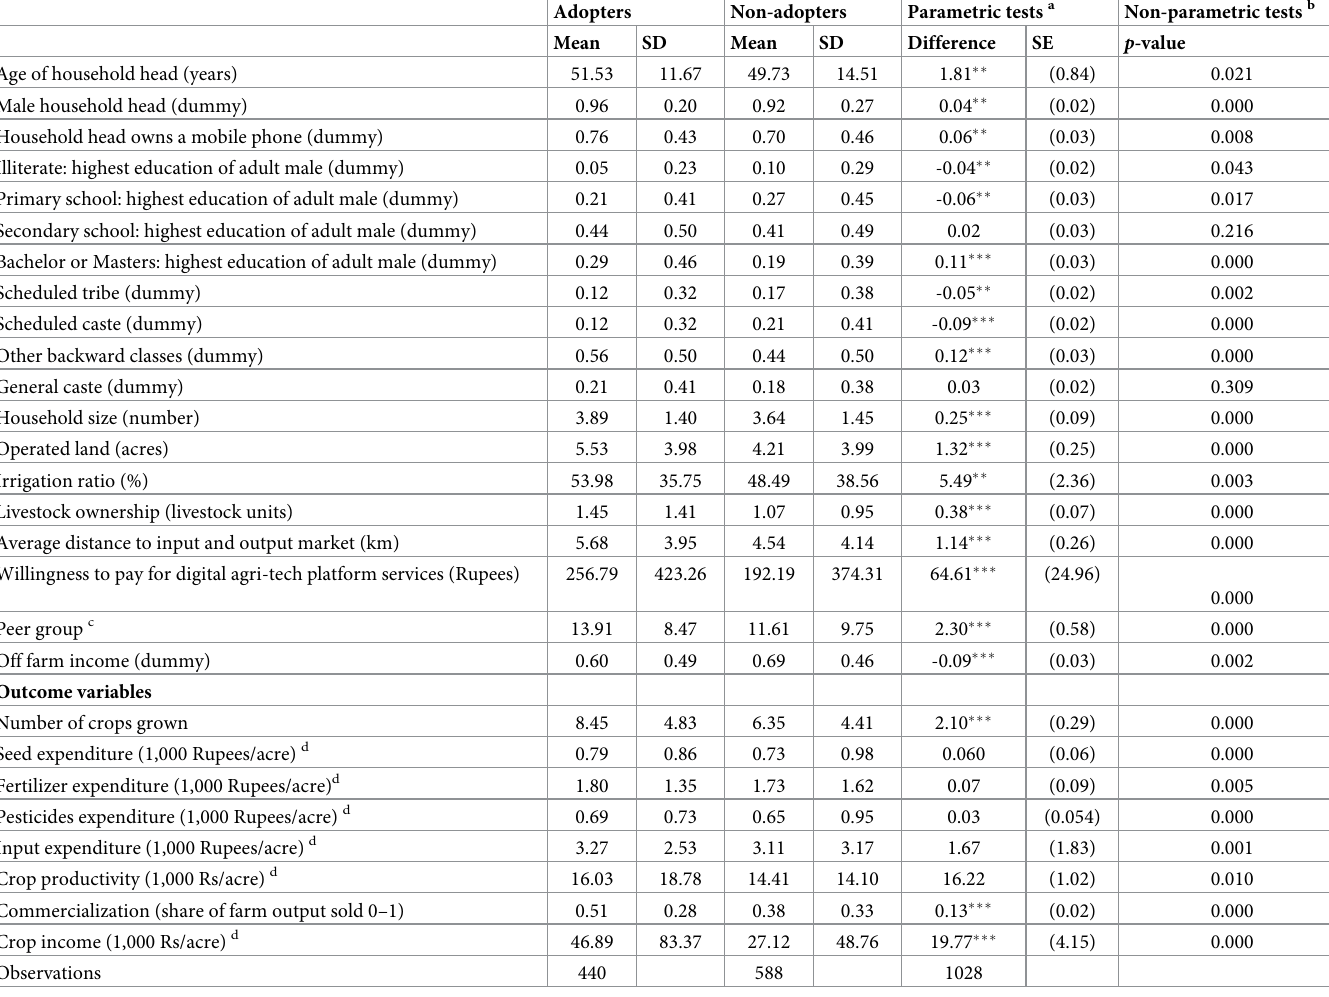
Table 2. Socioeconomic characteristics of adopters and non-adopters of digital extension services.